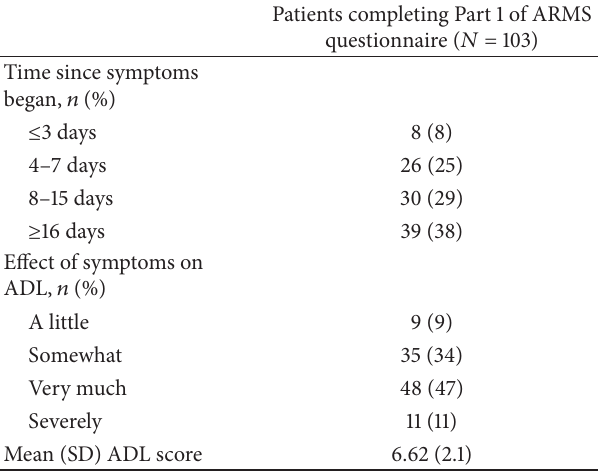
Table 2: Characteristics of current